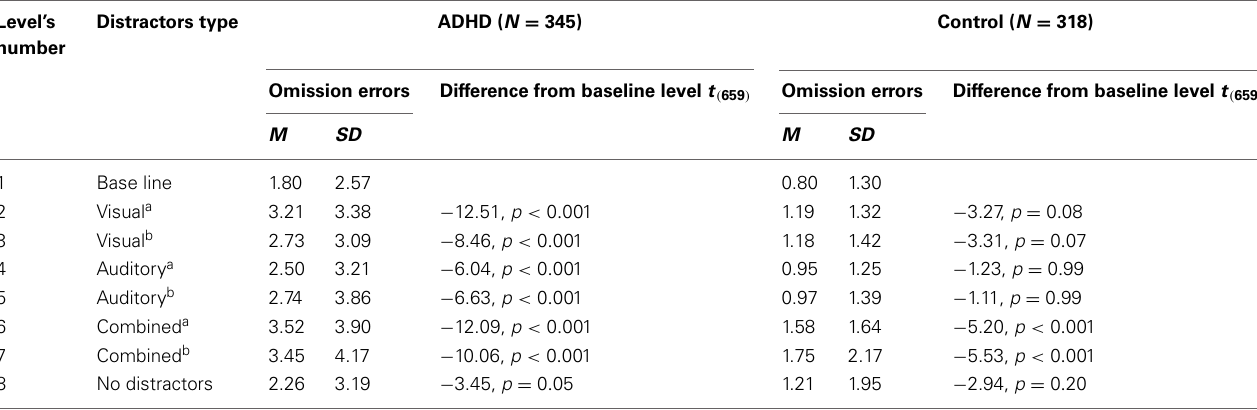
Table 2 | Level differences in Omission errors within each study